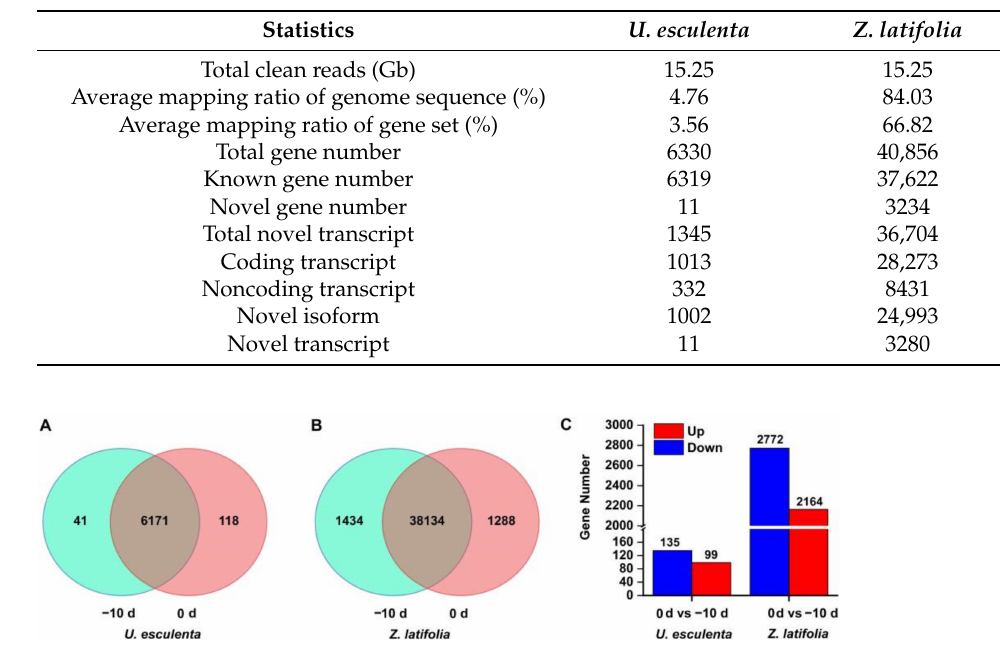
Table 1. Statistics for the transcriptome analysis of the Z. latifolia - U. esculenta interaction in the initial stage of stem-gall formation.